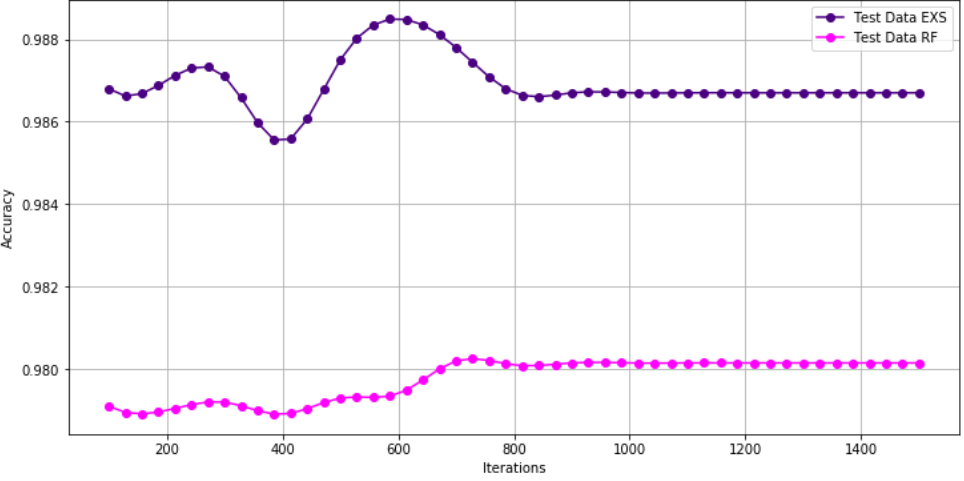
Figure 13. Distribution of the use of estimators in the classification of the time series elements.